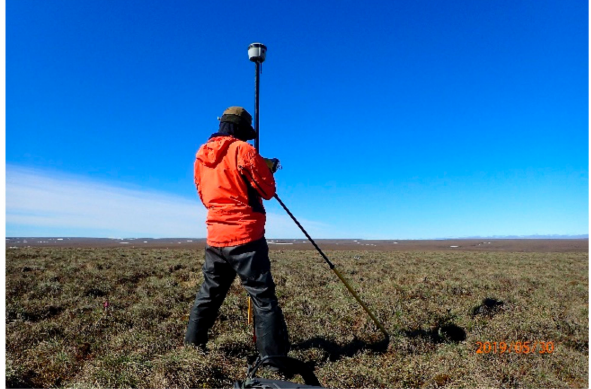
Figure A5. Field photo of IC on 30 May 2019.